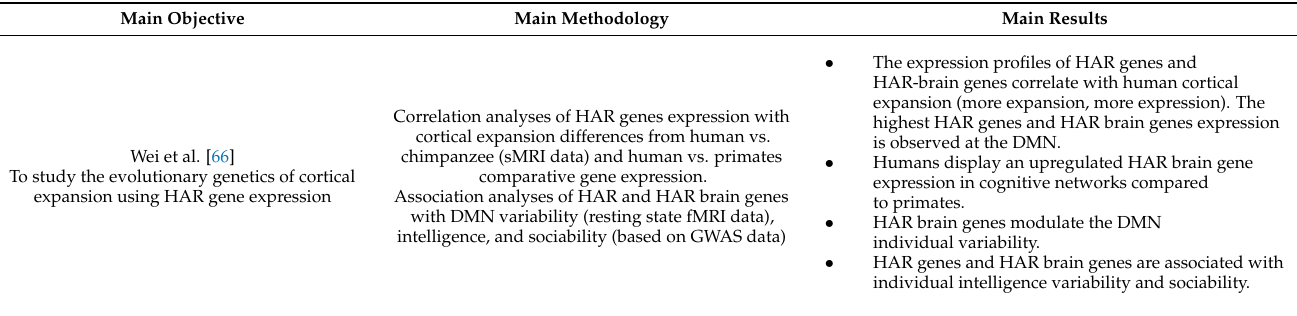
Table 3. Summarised findings of the studies assessing the role of HARs in brain and cognitive